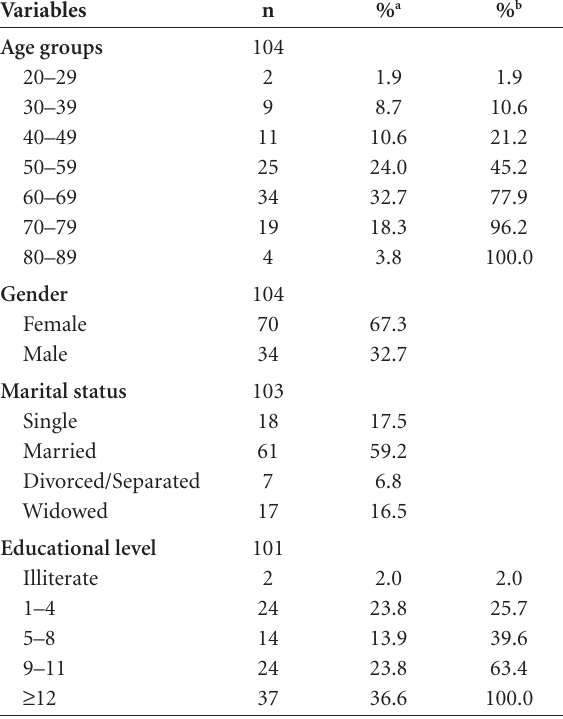
Table 1. Socio-demographic characteristics.